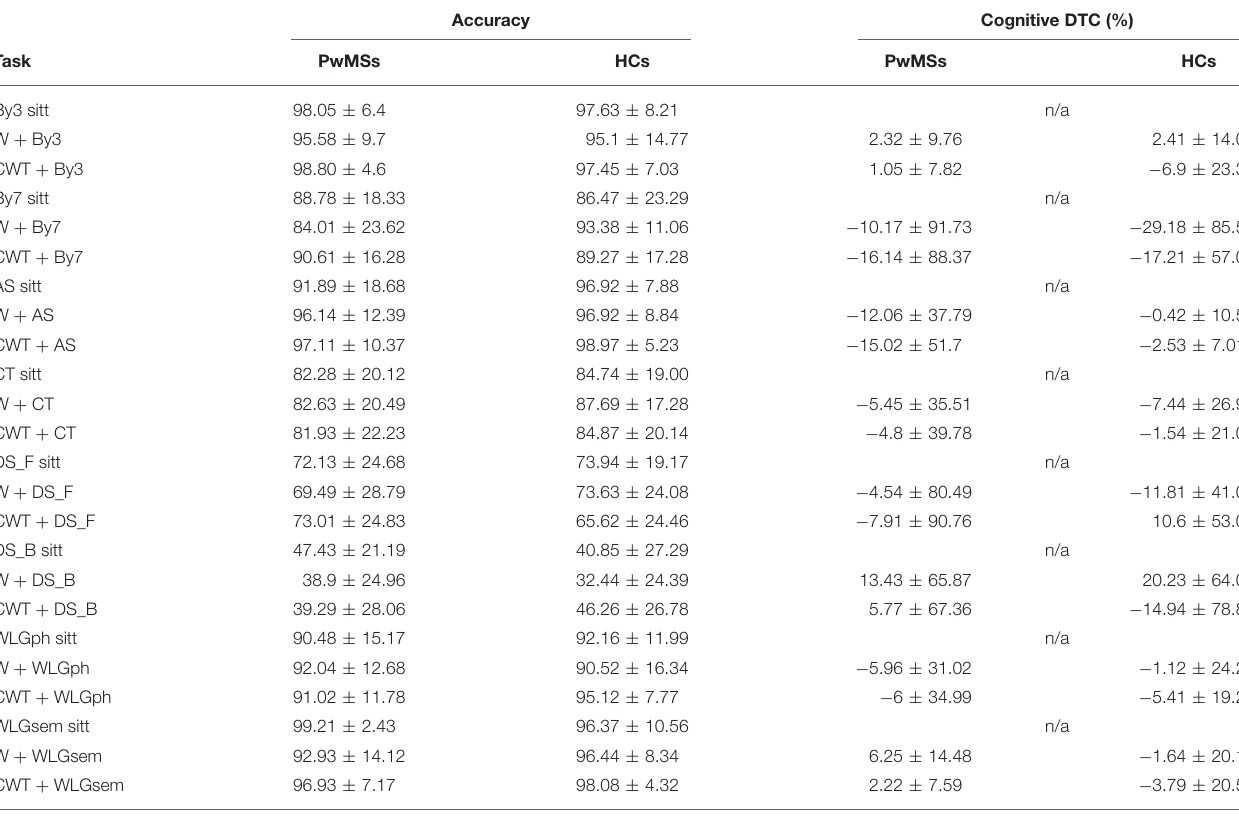
TABLE 3 | Mean accuracy of cognitive tasks and respective DTCs (percentage) during all the single cognitive and cognitive-motor DT conditions (mean ± SD) presented for both pwMSs and HCs. Accuracy